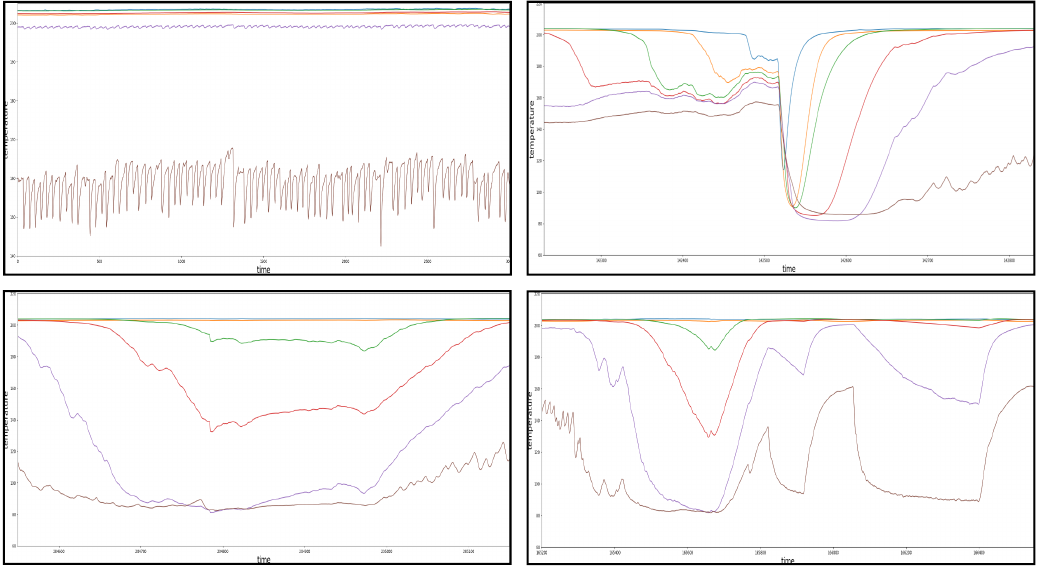
Figure 14. Graphical depiction of rare events (steady state for